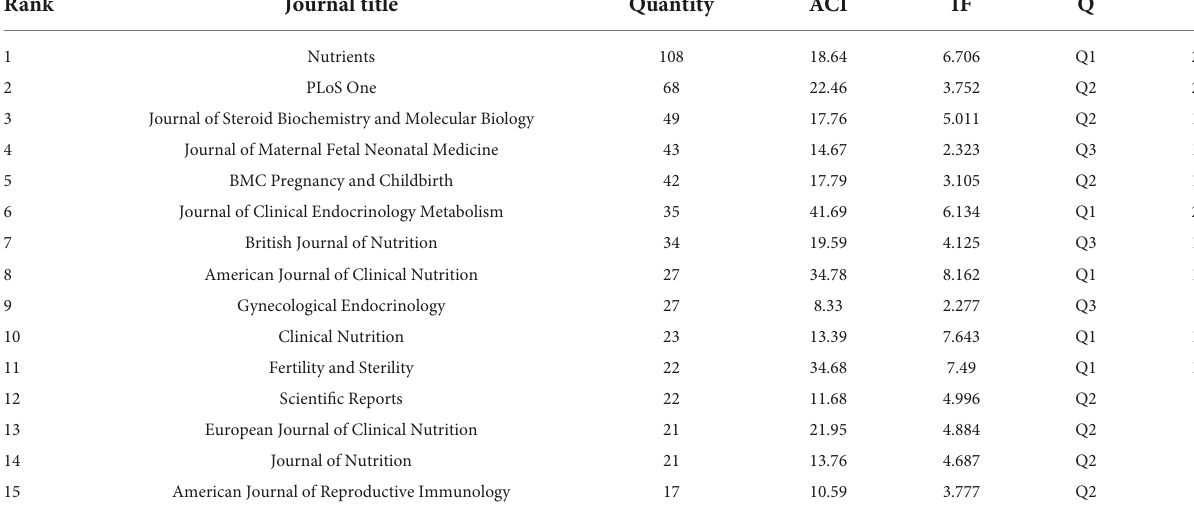
TABLE 3 Top 15 journals in the studies of vitamin D and reproductive